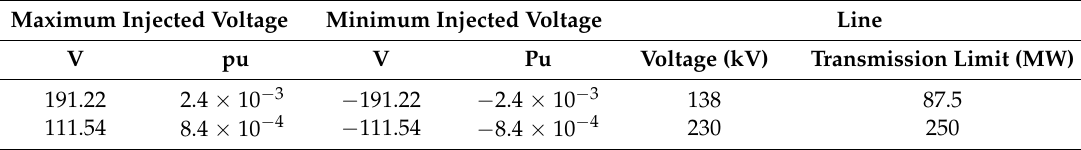
Table 1. Injected voltage of DPFC on different voltage level transmission